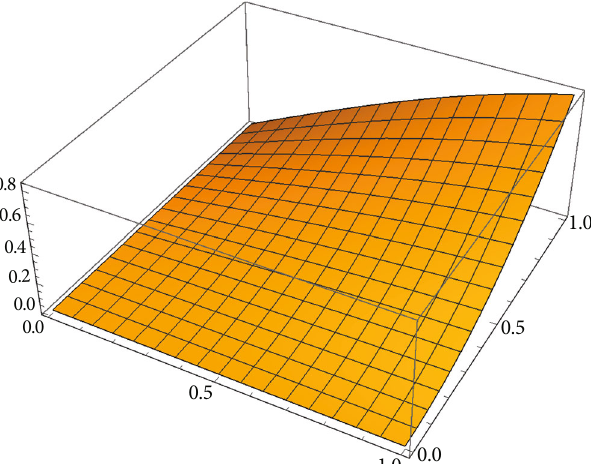
Figure 5: Approximate solution for Example 6.